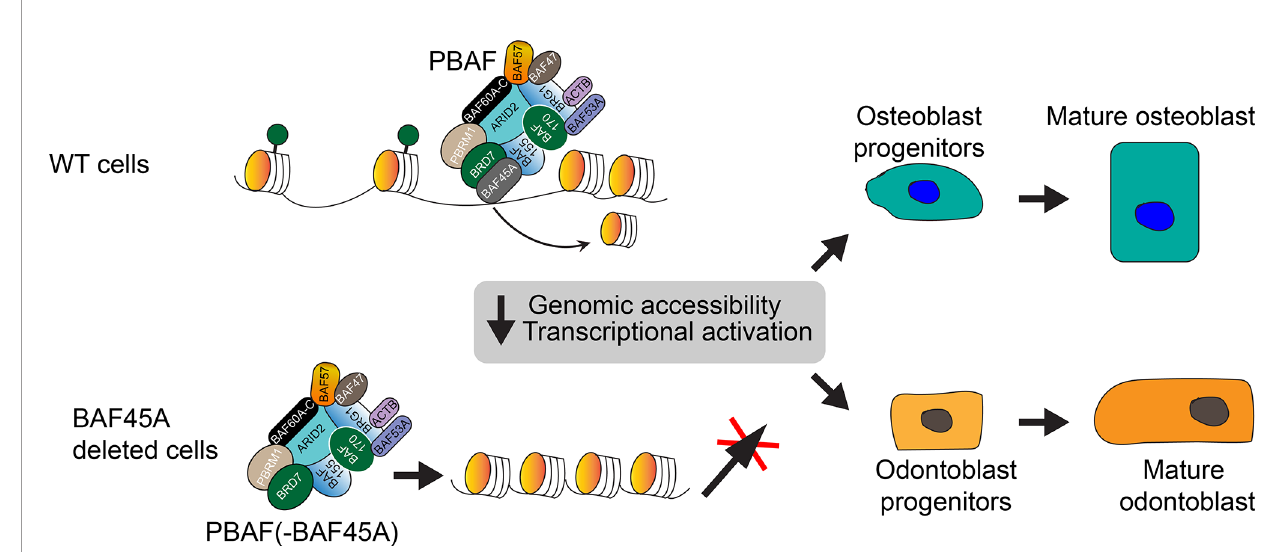
FIGURE 8 | Working model: BAF45A led PBAF chromatin remodeling activity regulates transcriptional activation in mineralized cells. The model shows that the BAF45A is an integral subunit of the mammalian PBAF chromatin remodeling complex. BAF45a, with the help of PBRM1, ARID2, BRD7, and BAF155, evict nucleosome and promote chromatin accessibility to initiates transcription. Depletion, mutation, or complete knockout of Baf45a in osteoblasts and odontoblasts destabilizes or switches the PBAF complex composition. Recruitment of such defective PBAF complex inhibits relevant bone or tooth tissue-speci fi c transcriptional events and gene expression. Finally, this inappropriate remodeling preventing the maturation of osteo or odonto-progenitor cells. Further biochemical assessment of BAF45A function with other PBAF subunits in vivo will help to understand chromatin remodeling in mineralized tissues